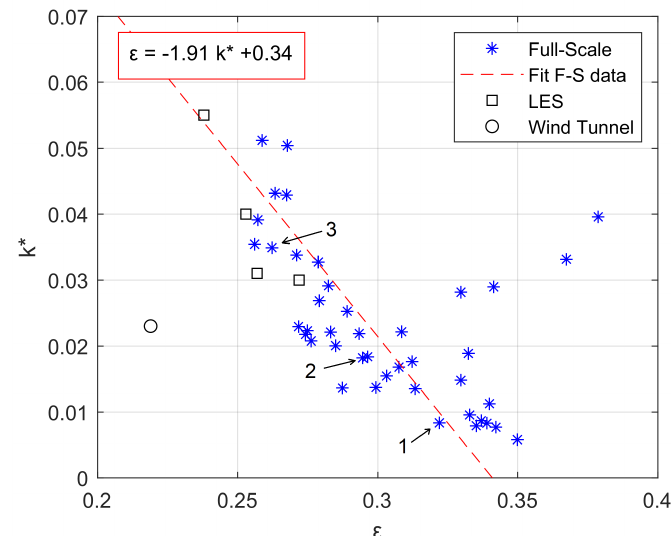
Figure 11. Relationship between wake growth k ∗ and wake width at the rotor ε . In blue all the data collected during the experiment, in dashed red the linear fit to the full-scale field data presented in Equation (17). In black the data obtained from [11]. Labels numbered 1 to 3 indicate the cases presented in Figure 9.